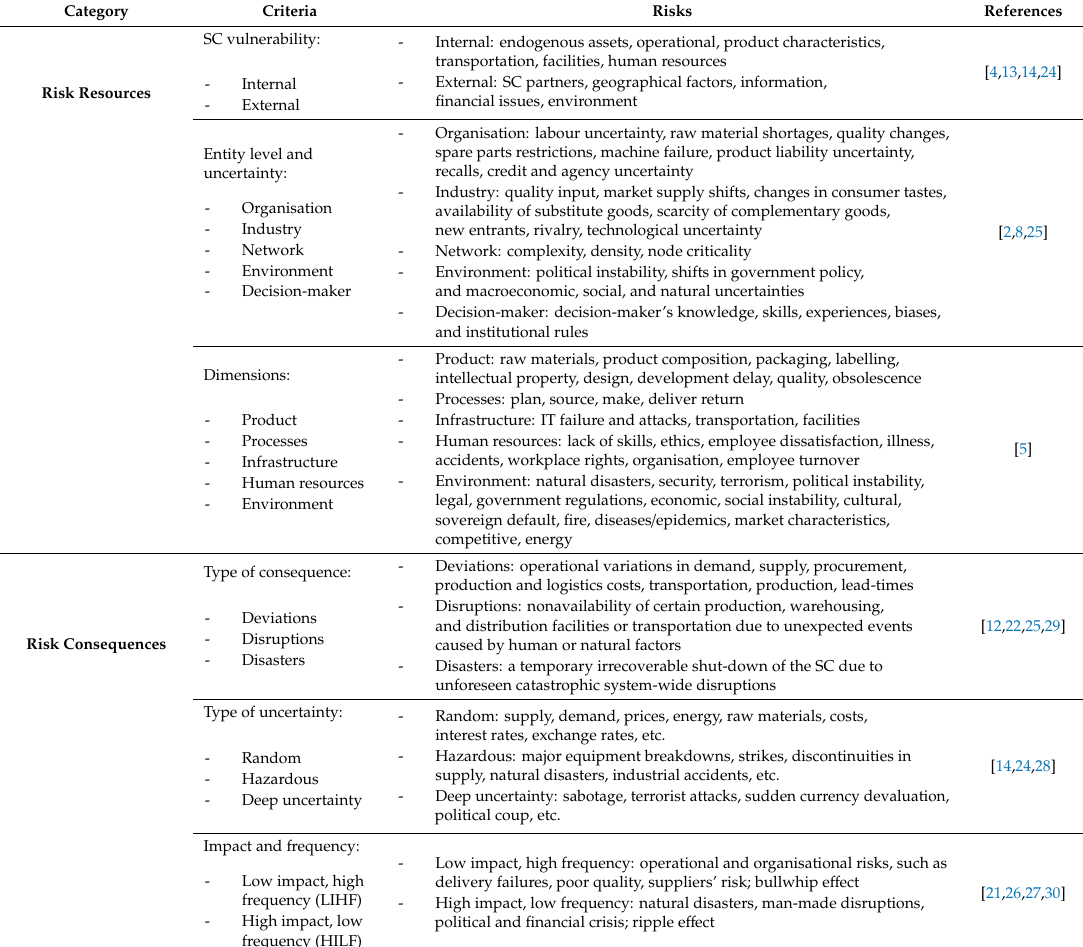
Table 1. A supply chains (SC) risks